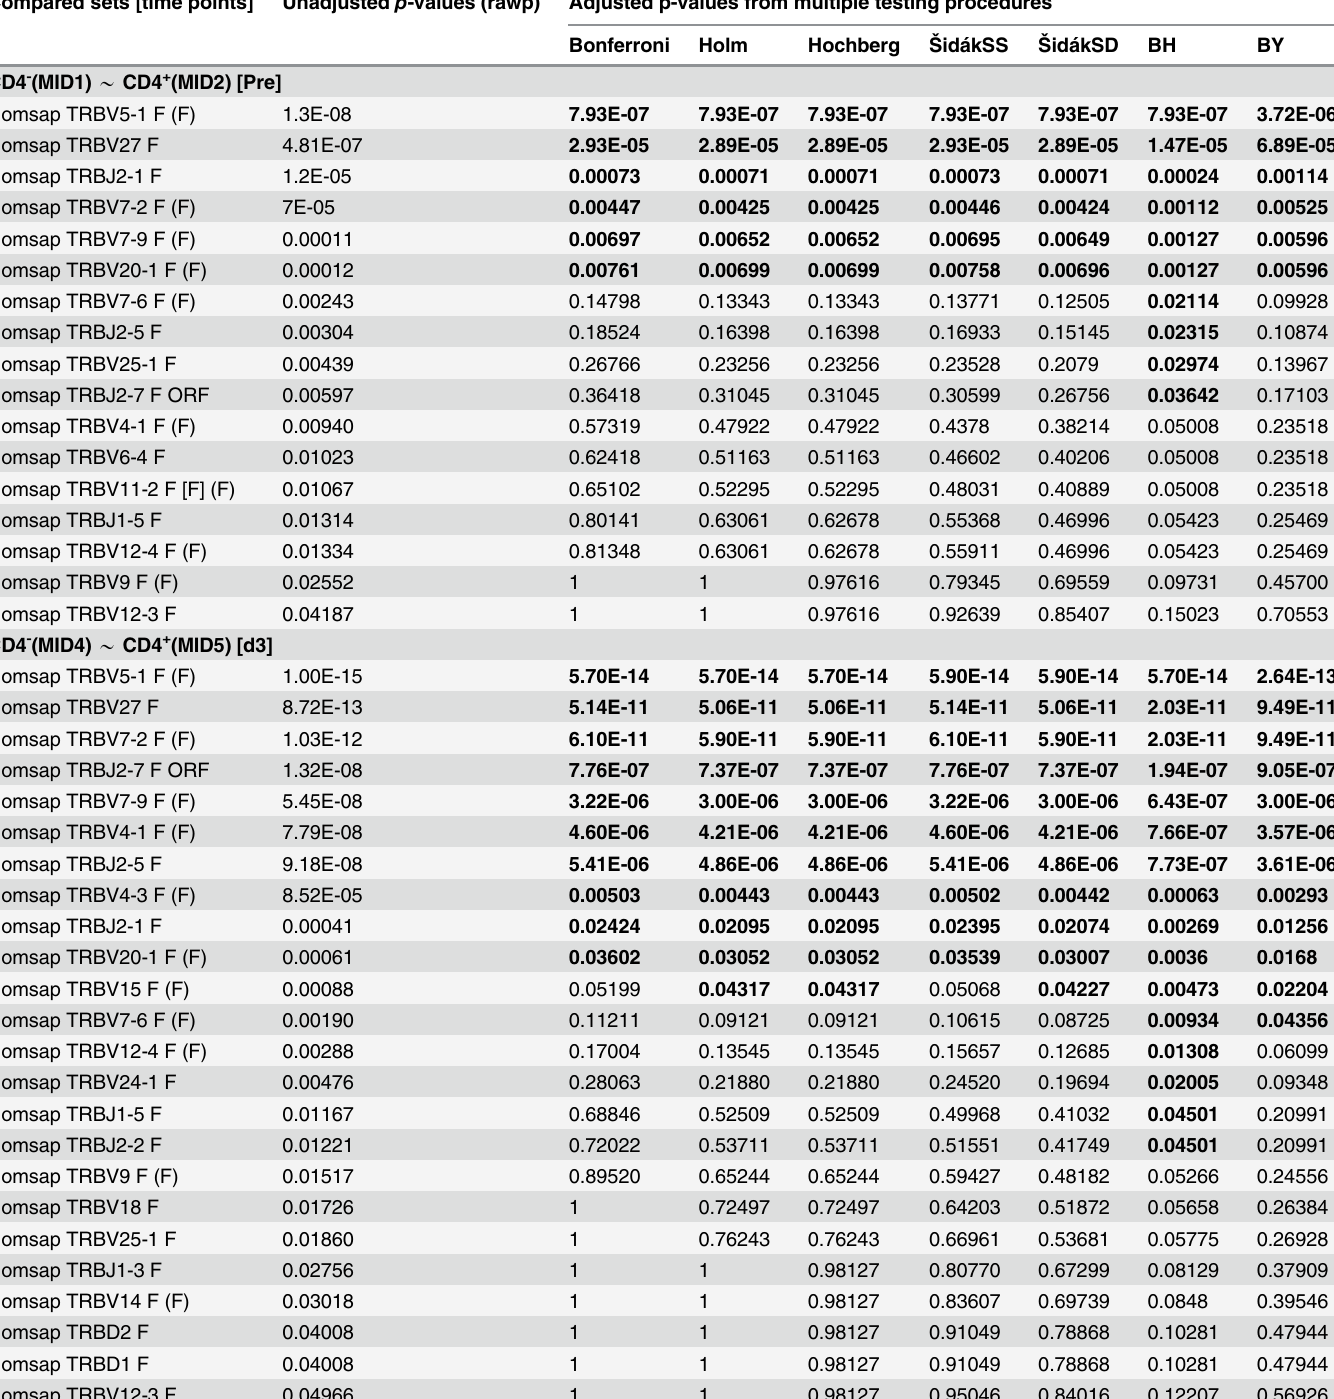
Table 3. Unadjusted and adjusted p -values from multiple testing procedures. Unadjusted p -values (rawp) and adjusted p -values from multiple testing procedures were calculated, for the significance of the differences in proportions for Homo sapiens TRB IMGT clonotypes (AA) with a gene of a given group (TRBV, TRBD or TRBJ), between two T cell populations (CD4 - and CD4 + ) at four time points (Pre, d3, d8 and